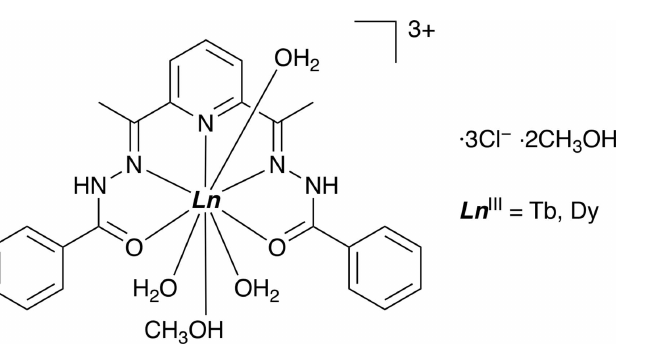
Table 1 Selected geometric parameters (A˚ , (cid:3) ) for the Tb III and Dy III complexes.